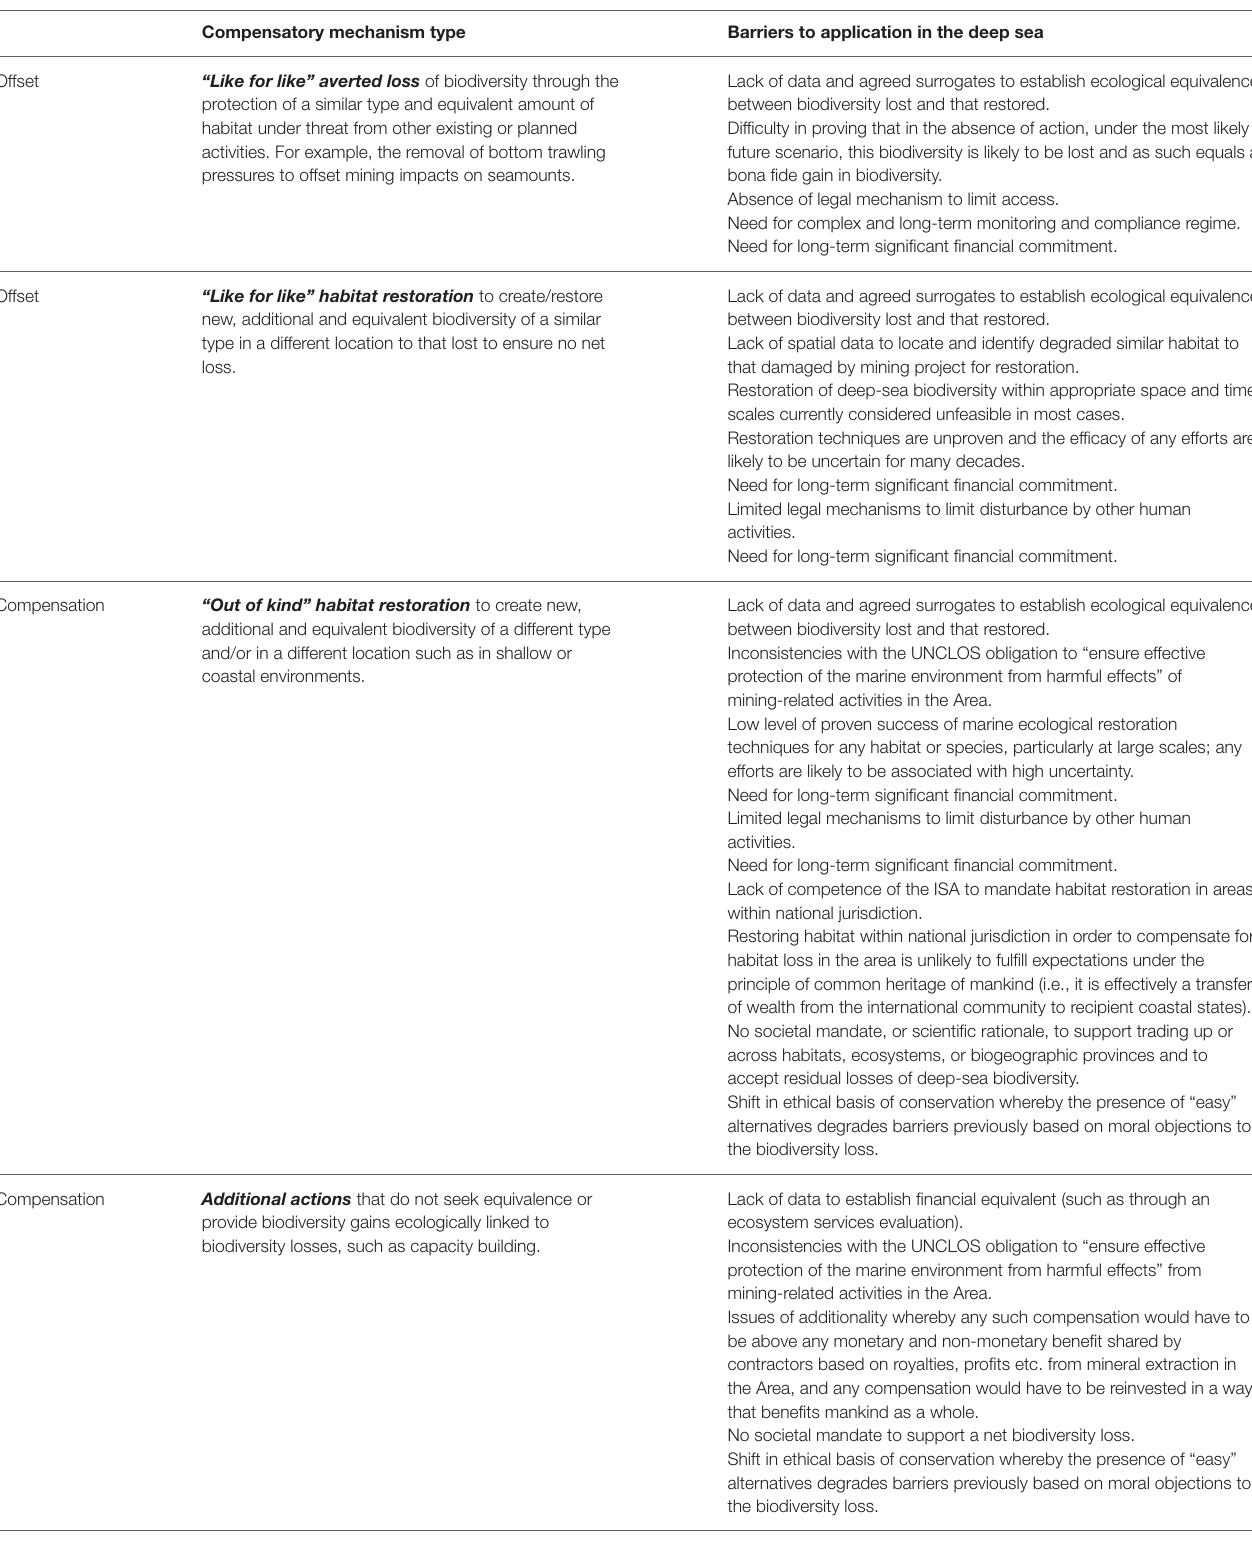
TABLE 1 | Options for the final step of the mitigation hierarchy and barriers to their effective application in the deep